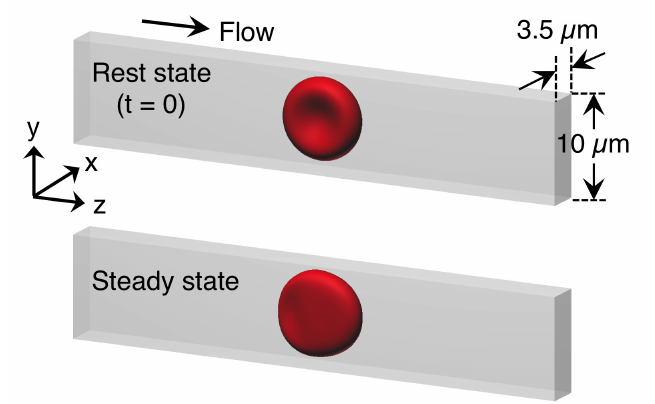
Figure 1. Computational domain to reproduce a translating red blood cell (RBC) in the narrow rectangular microchannel. The domain mimicked a microfluidic device as shown in Figure